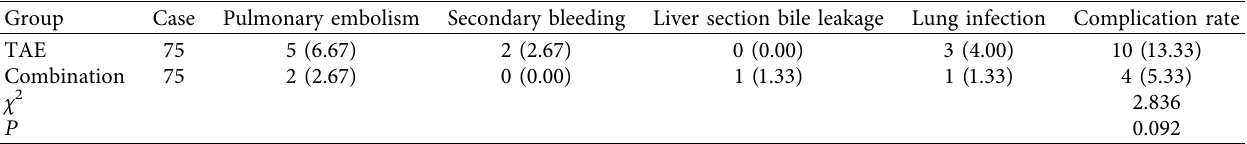
Compared with the same group before operation, ∗ P < 0 . 05. Table 4: Comparison of postoperative complications between the two groups ( n